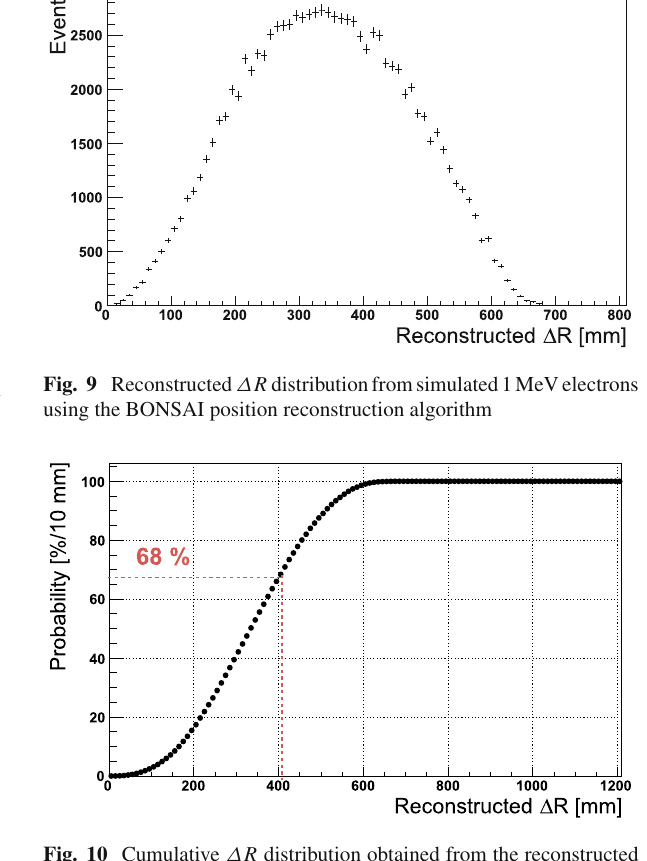
Fig. 10 Cumulative Δ R distribution obtained from the reconstructed Δ R distribution displayed in Fig.